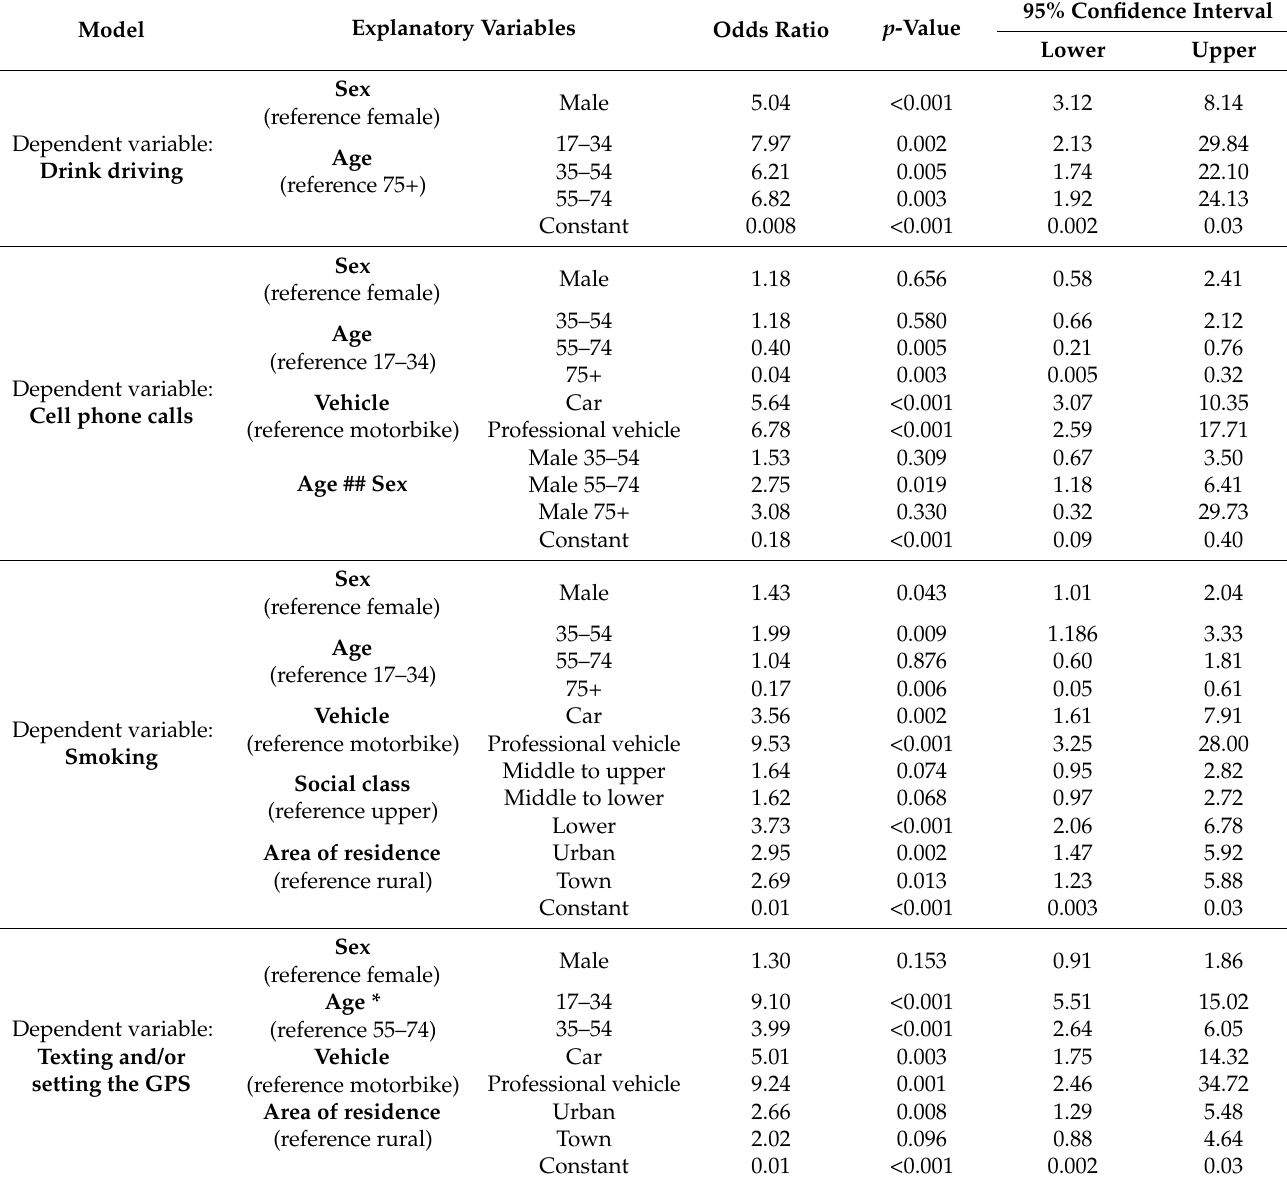
Table 7. Logistic regression models for drivers’ characteristics that affect behavior that limits concentration while driving. Model Explanatory Variables Odds Ratio p -Value